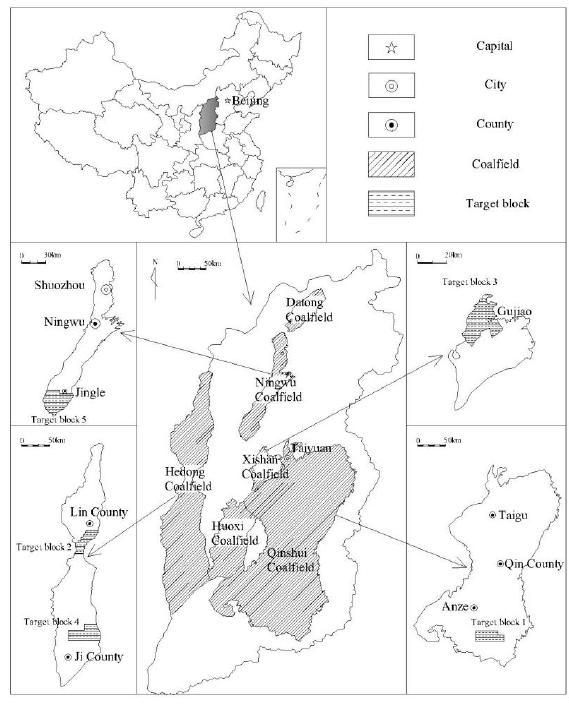
Figure 1. Shanxi location and target blocks location map.